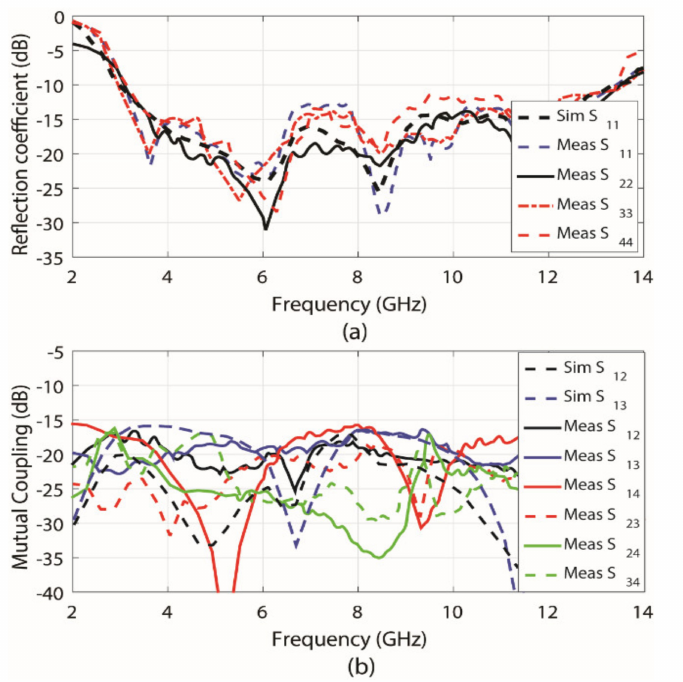
Figure 6. Simulated and measured S-parameters of the 4 ports ( a ) reflection ( b ) mutual